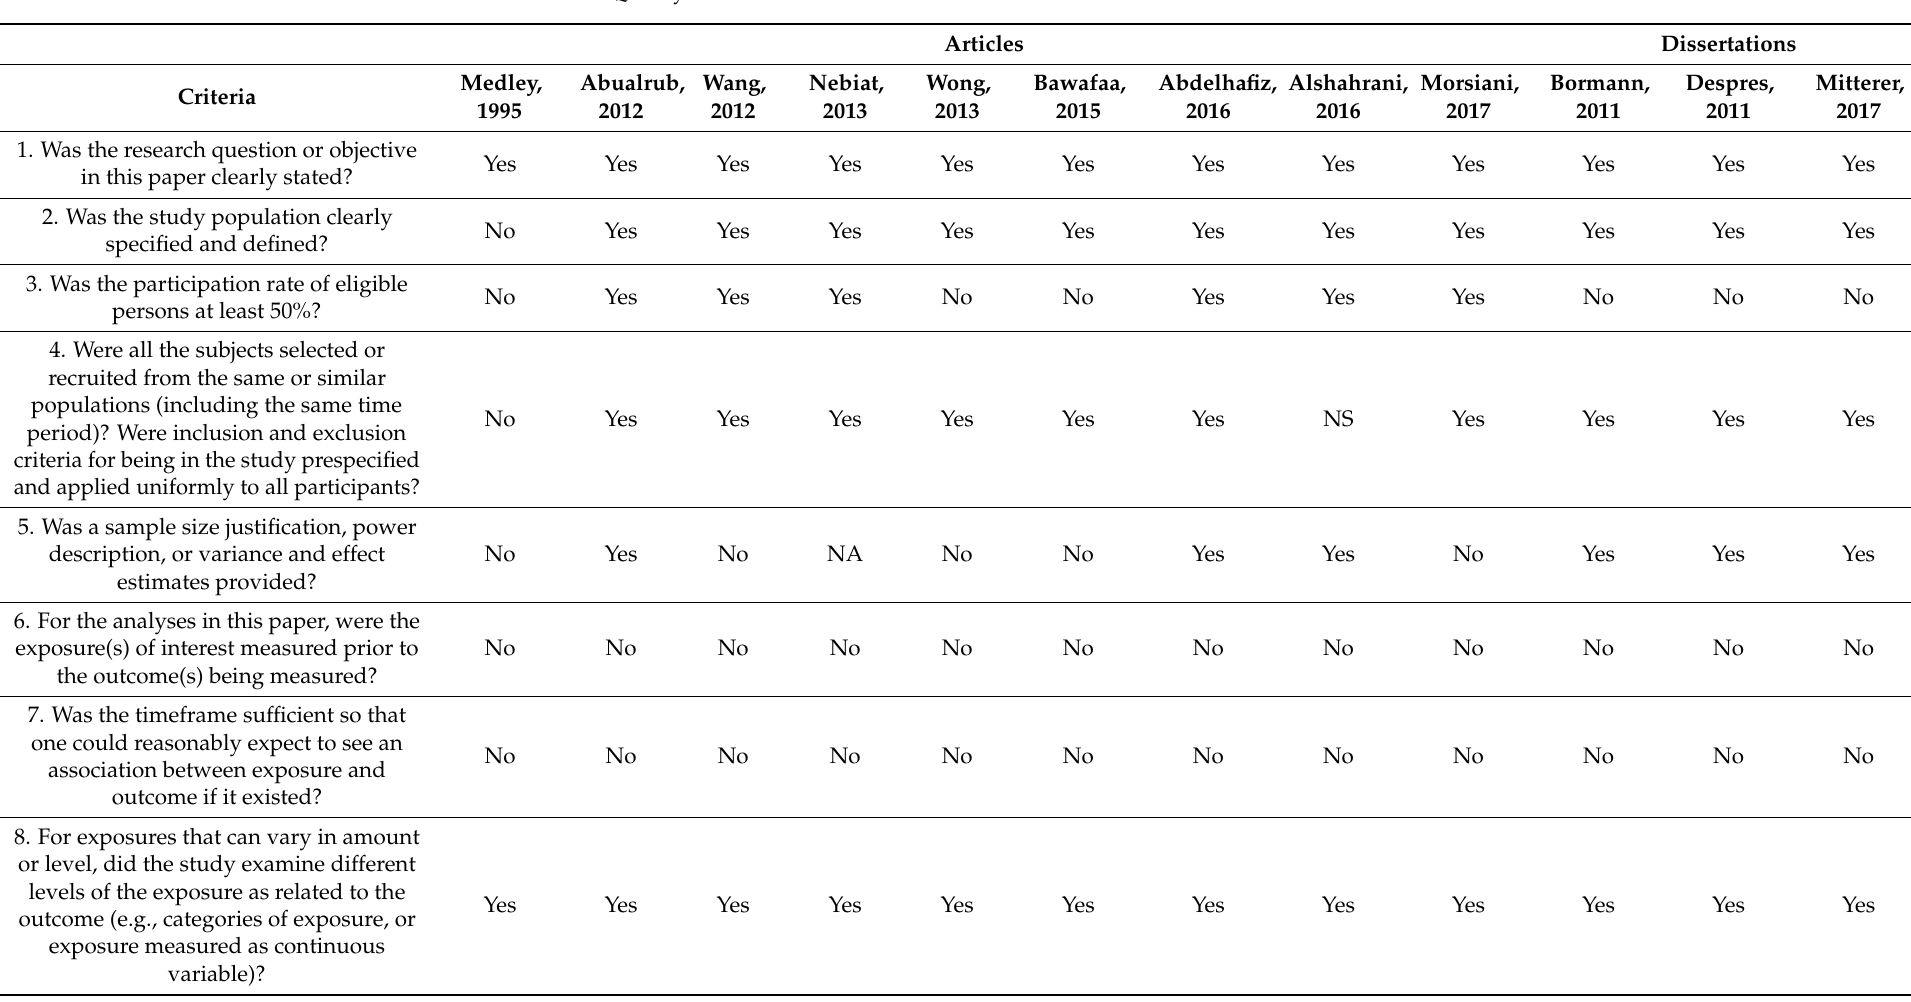
Table 3. Quality Assessment Tool for Observational Cohort and Cross-Sectional